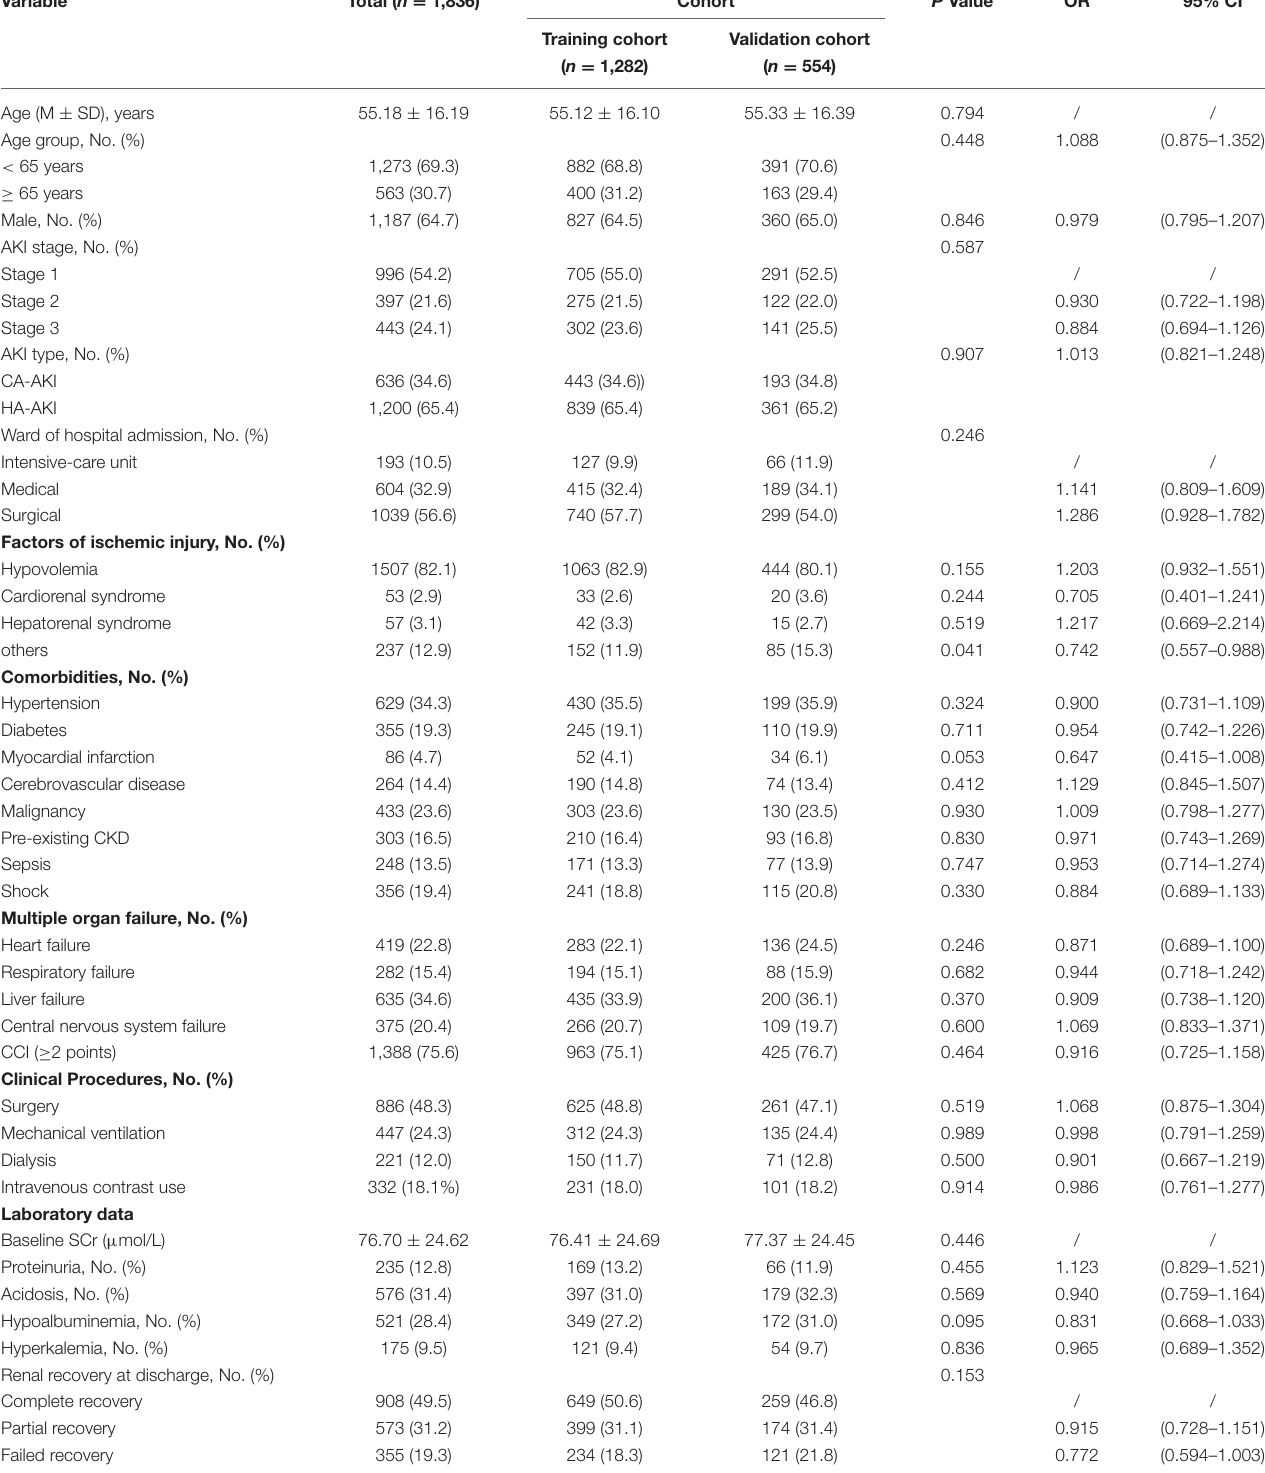
TABLE 1 | Characteristics of the hospitalized ischemic patients in the training and validation cohort.